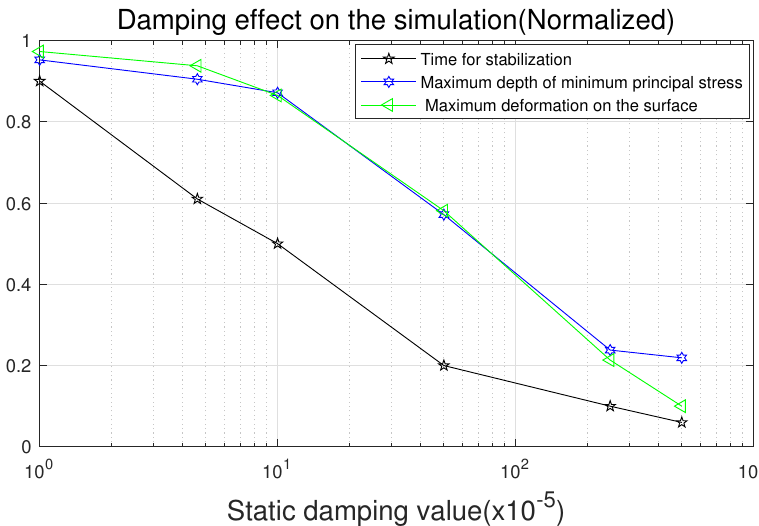
Figure 13. Normalized effect on the FE simulation according to static damping